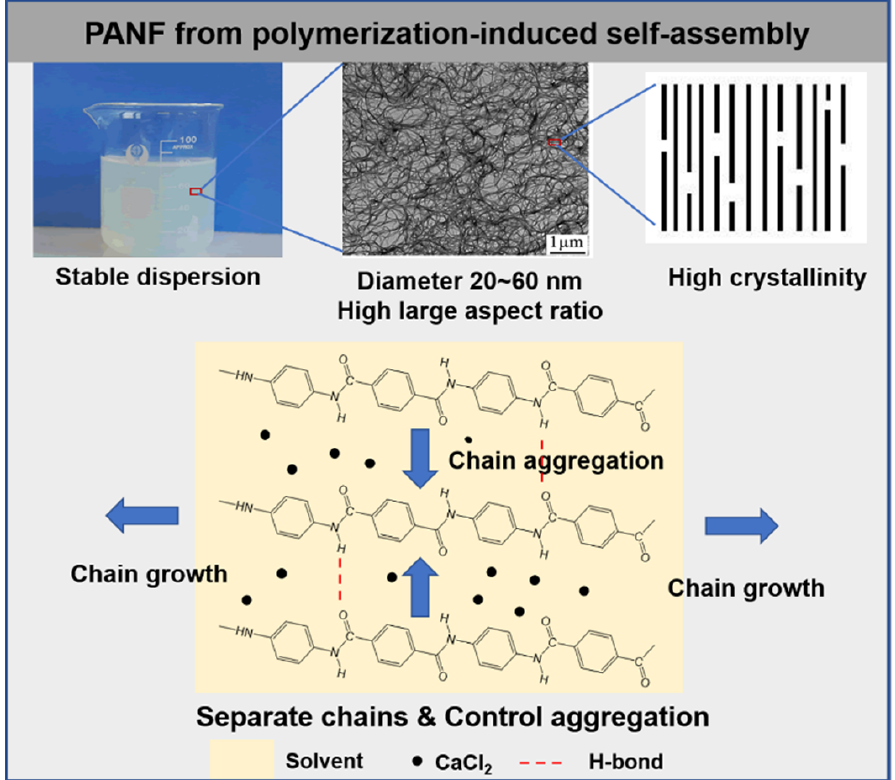
Figure 6. Fabrication of PANF via polymerization-induced self-assembly strategy. In addition to the di-component copolymerization system of PPD and TPC, the polymerization-induced assembly strategy is also suitable for the fabrication of aramid nanofibers with the copolymerization of third co-monomers. In order to illustrate this, Shi et al. [44] separately introduced three kinds of third monomer, m -phenylenediamine, 4,4-diaminodiphenyl ether and 2,5-dichloro-1,4-phenylenediamine, into the polymerization- induced self-assembly process of PPTA, and nanofiber aqueous dispersions were all ob- tained with subtle differences in micromorphology (Figure 7A). The side groups of copoly- merized aramids were of benefit for the decreasing of ANF diameter. Similarly, the third monomer, 2-(4-aminophenyl)-5-aminobenzimidazole, was also introduced to participate in the polymerization-induced self-assembly of PPTA, and the ribbon-like nanofiber network formed in the process of aggregation (Figure 7B). The introduction of heterocyclic monomer destroyed the chain’s regularity, but the thermal stability of the PPTA copolymer was further improved